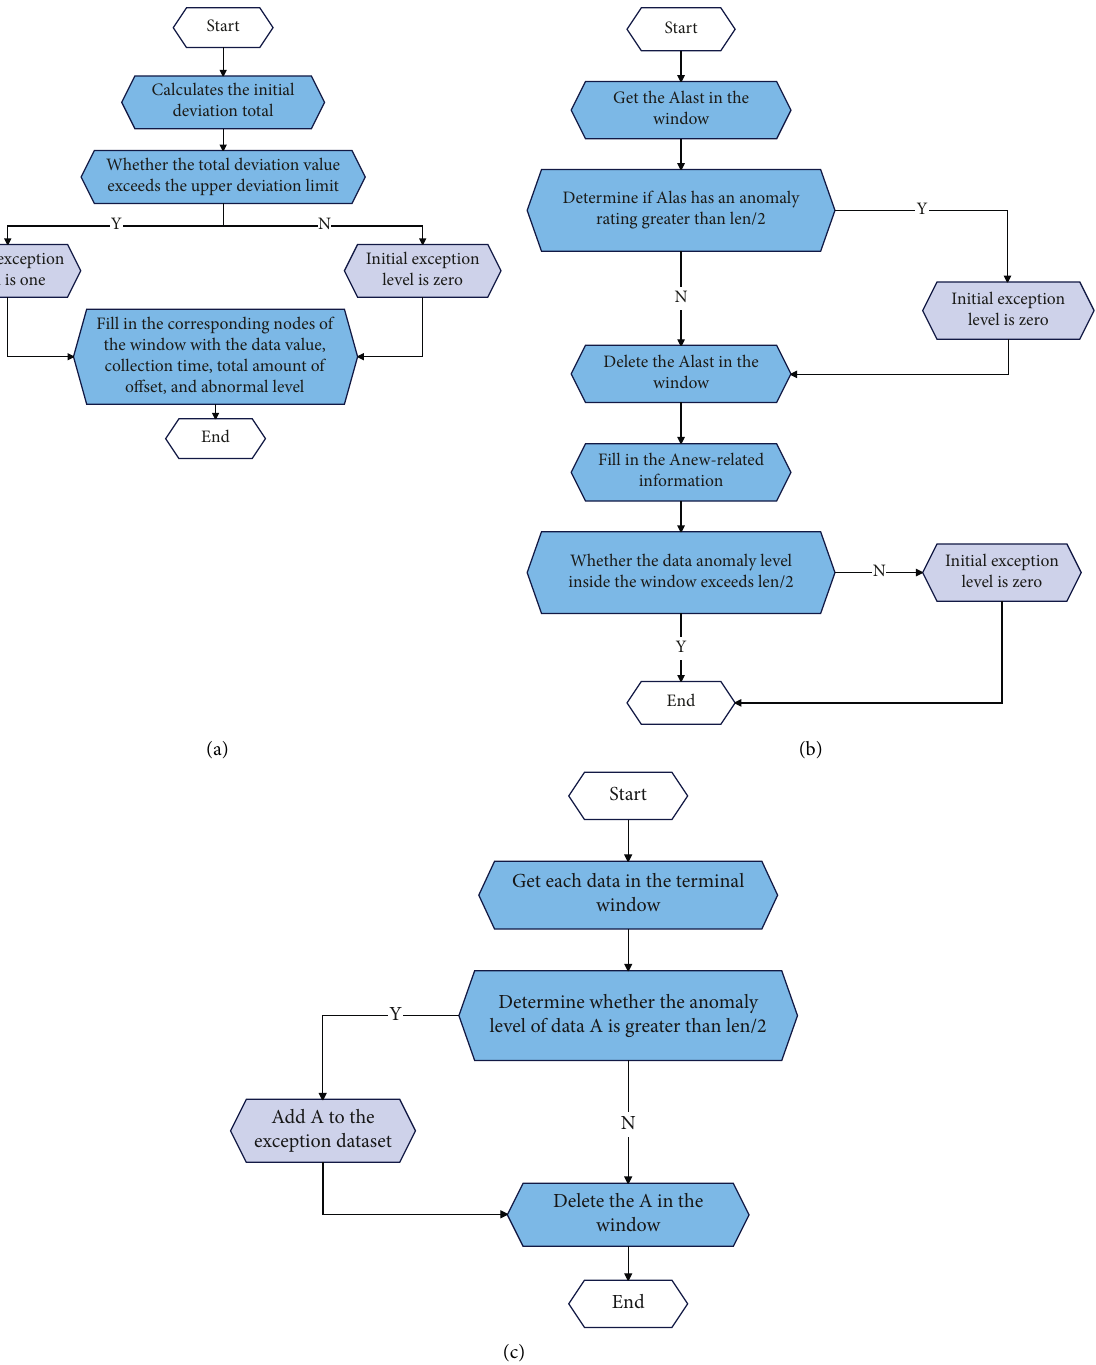
Figure 2: Algorithm flow chart. (a) Window initialization flowchart. (b) Window sliding flow chart. (c) Clear window flow